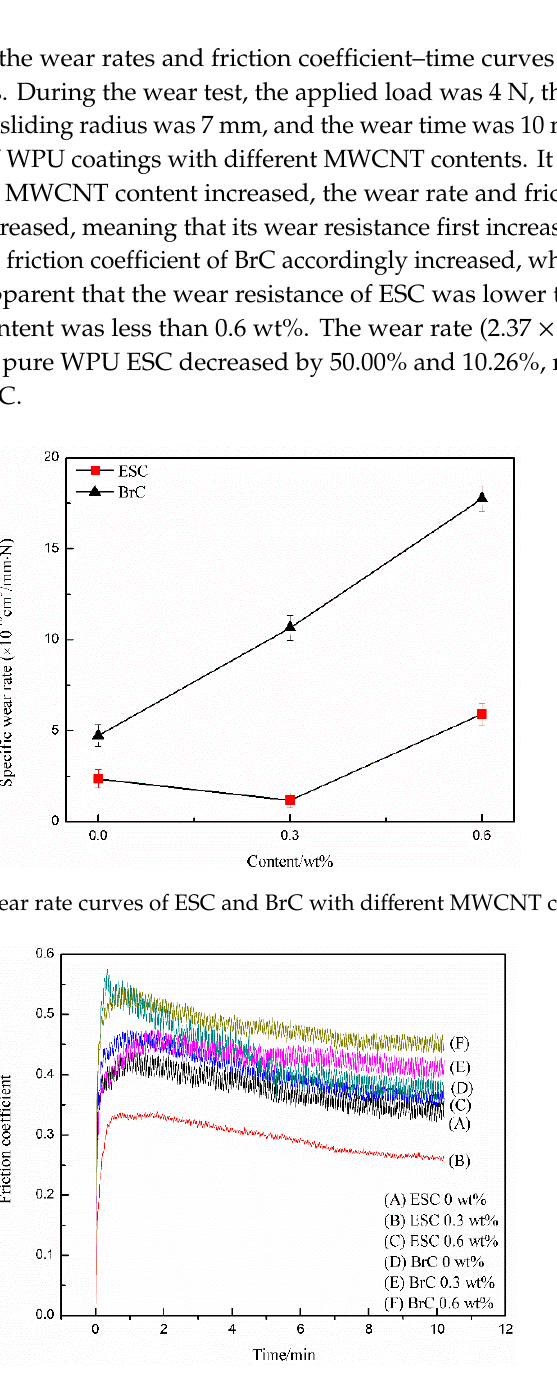
Figure 5. Friction coefficient—time curves of WPU coatings with different MWCNT contents.